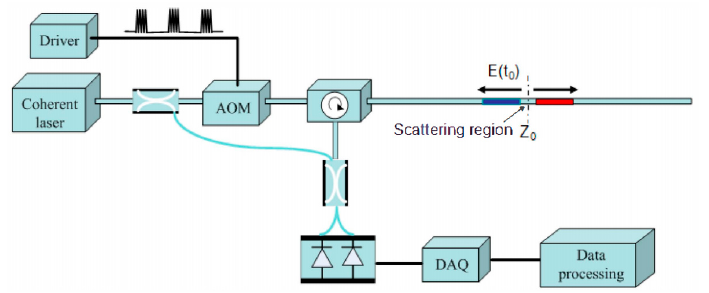
Figure 2. Typical heterodyne coherent detection scheme [22].